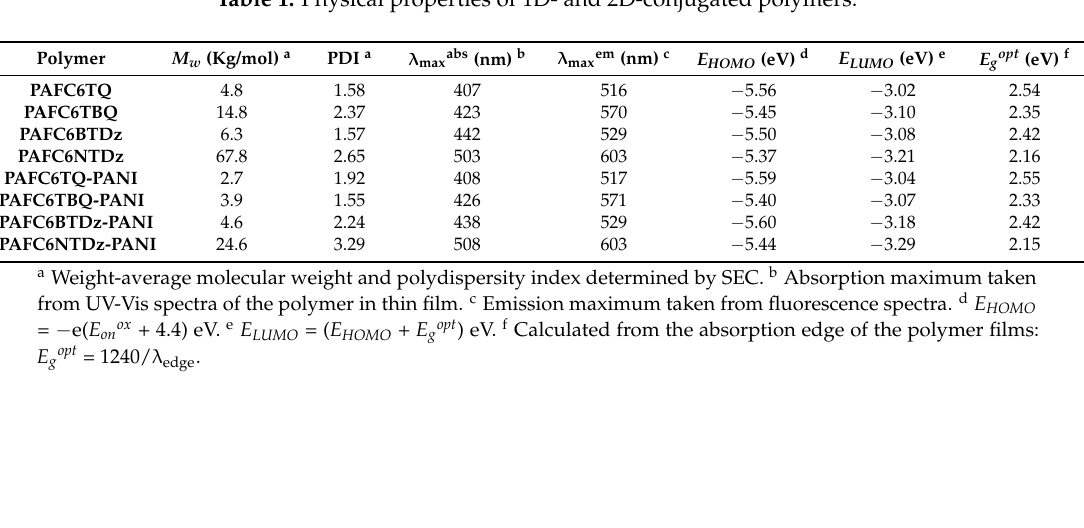
Table 1. Physical properties of 1D ‐ and 2D ‐ conjugated polymers.